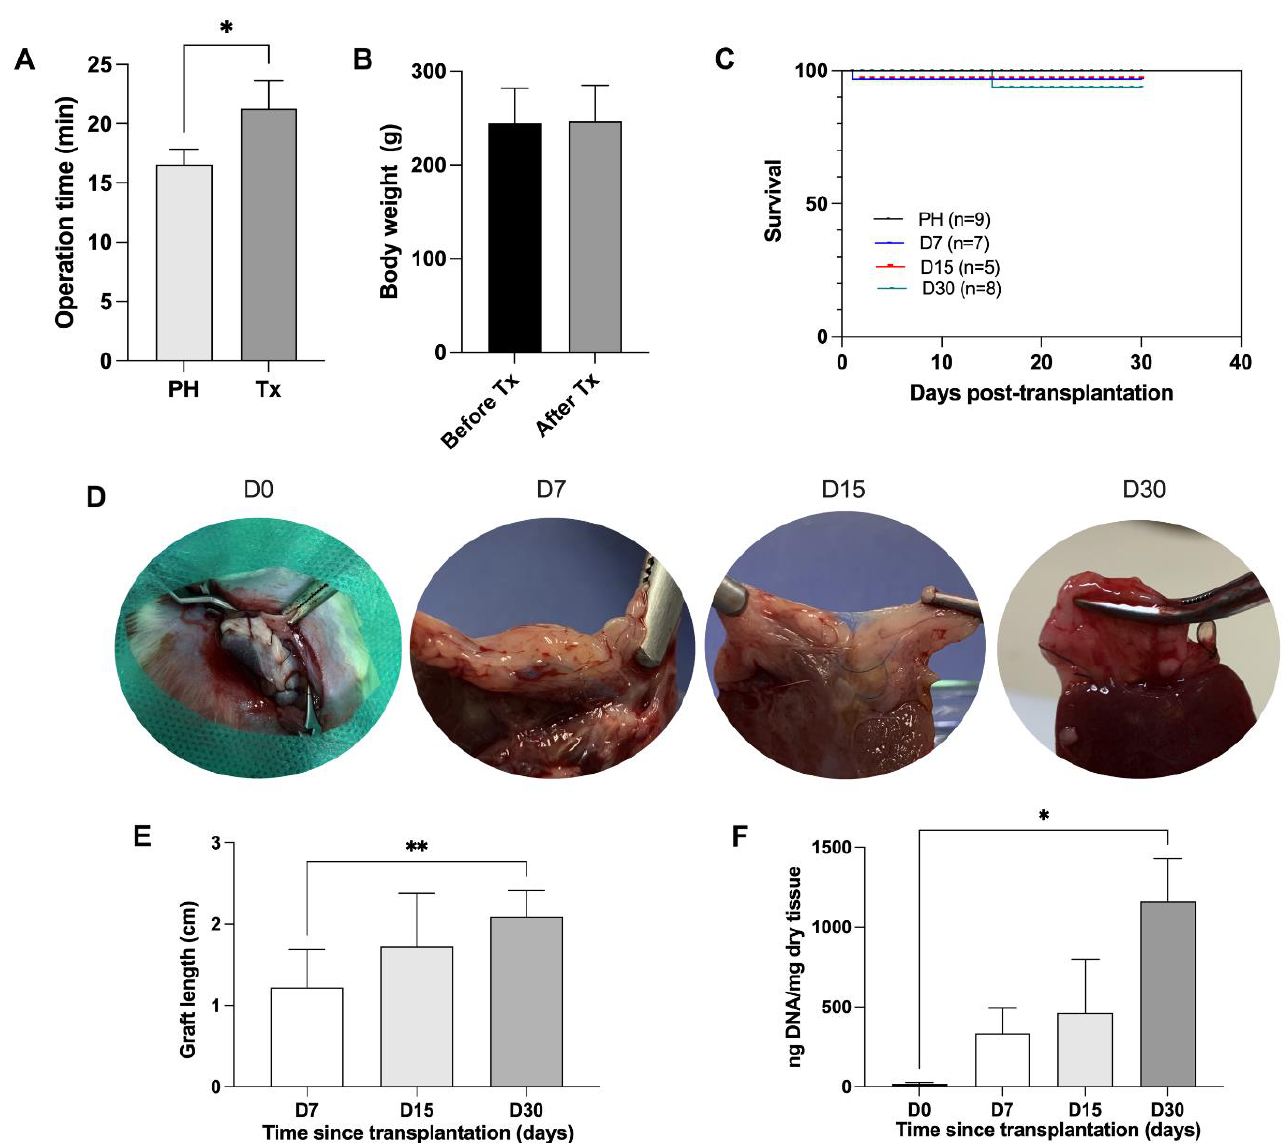
Figure 5. Acellular liver scaffold transplantation into rats with cirrhosis. Operation time (partial hepatectomy group, PH, n = 9 vs. transplanted group, Tx, n = 20) ( A ), body weight ( B ), and probability of survival of recipient animals subjected to ALS transplantation 7, 15, and 30 days post-transplantation compared to only partially hepatectomized rats (PH) ( C ) (log-rank: Mantel–Cox test). Gross appearance of ALS at transplantation (D0) and D7, D15, and D30 days post-transplantation ( D ). Graft size analysis at 7, 15, and 30 days post-transplantation ( E ) ( n = 5). DNA content quantification in transplanted grafts before and 7, 15, and 30 post-transplantation ( n = 3). Significant differences were assessed by using Student’s t -test ( A , B ), one-way ANOVA followed by Tukey’s test ( E ), and Friedman’s test ( F ).* p < 0.05, ** p < 0.005 .